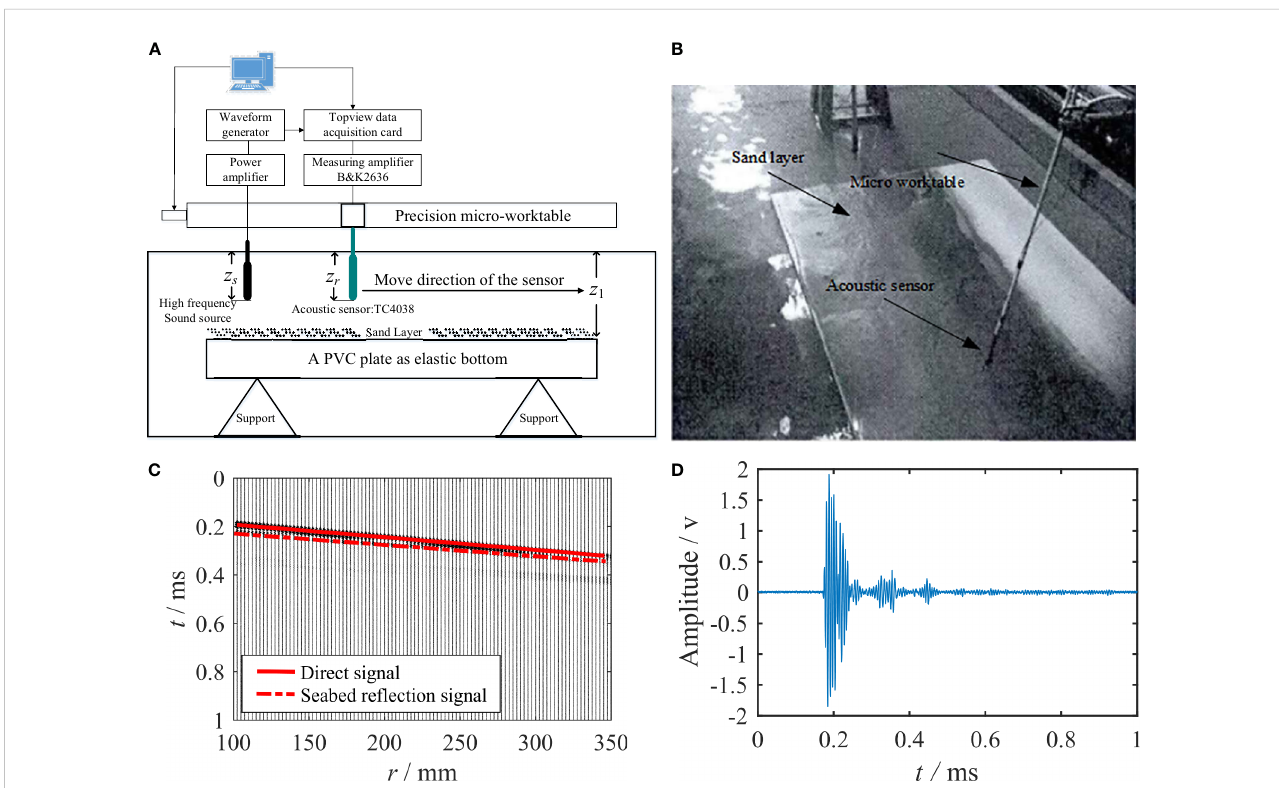
FIGURE 9 Experimental setup with the measuring instruments and equipment and time domain waveform. (A) Diagram of the layout of the experimental measurement system, (B) Photographic image of the movable micro-worktable for the measurement equipment, (C) Time domain waveform arrival time, (D) Time domain waveform at position